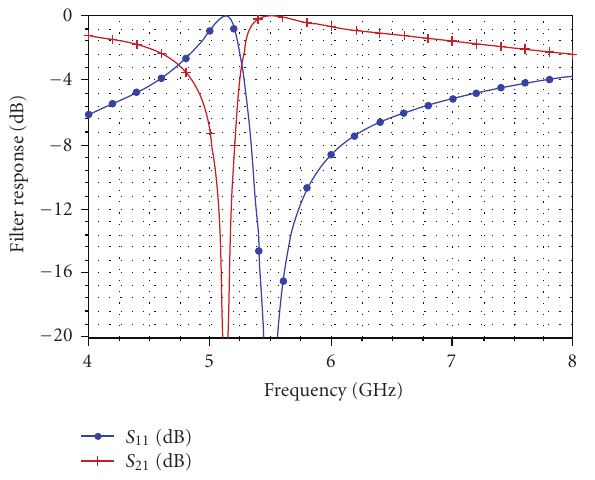
Figure 5: Frequency response of an FBAR coupled to a hairpin with edge coupling.